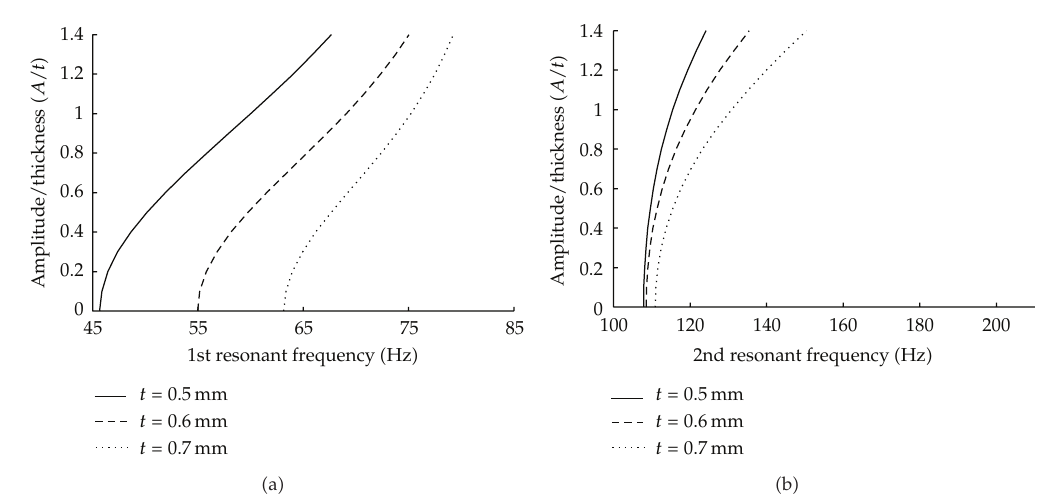
Figure 2: (cid:3) a (cid:6) The vibration amplitude ratio versus the 1st nonlinear resonant frequency (cid:3) t (cid:7) 0 . 5, 0.6, 0.7mm (cid:6) . (cid:3) b (cid:6) The vibration amplitude ratio versus the 2nd nonlinear resonant frequency (cid:3) t (cid:7) 0 . 5, 0.6, 0.7mm (cid:6)